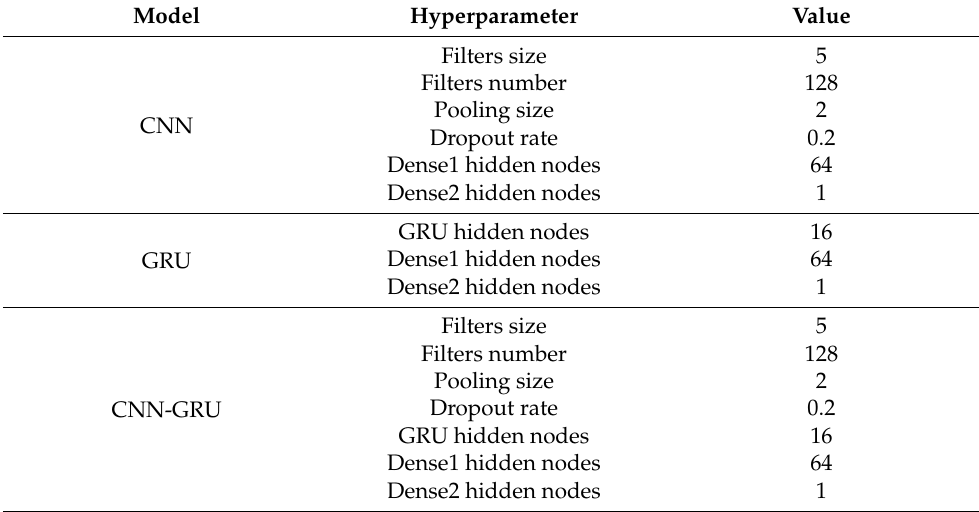
Table 5. Main hyperparameters of the CNN, GRU, and CNN-GRU.